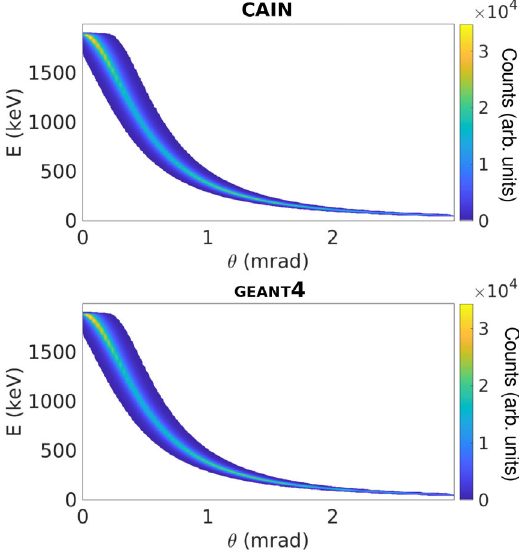
FIG. 5. Energy of emitted photons E versus polar emission angle θ for the NewSUBARU photon beam, simulated with CAIN and GEANT 4 .